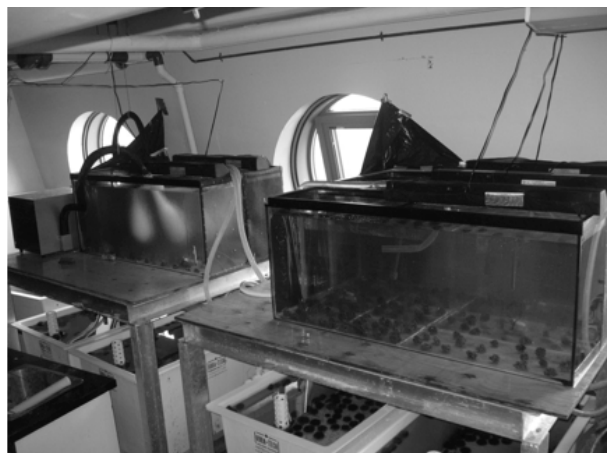
Figure 5. Experimental tank layout at the Ocean Sciences Centre at Logy Bay, NF. High-light right end of each tank is adjacent to large port-like window and has fluorescent lights overlying. Oppo- site, low-light ends of tanks shielded with opaque plastic sheet. Note cooling probes, coated with ice, placed in 2 and 4 ◦ C tanks on left. Three light segments (left to right: low light, ll; mid-light. ml; high light, hl) with their emplaced specimens can be seen in right